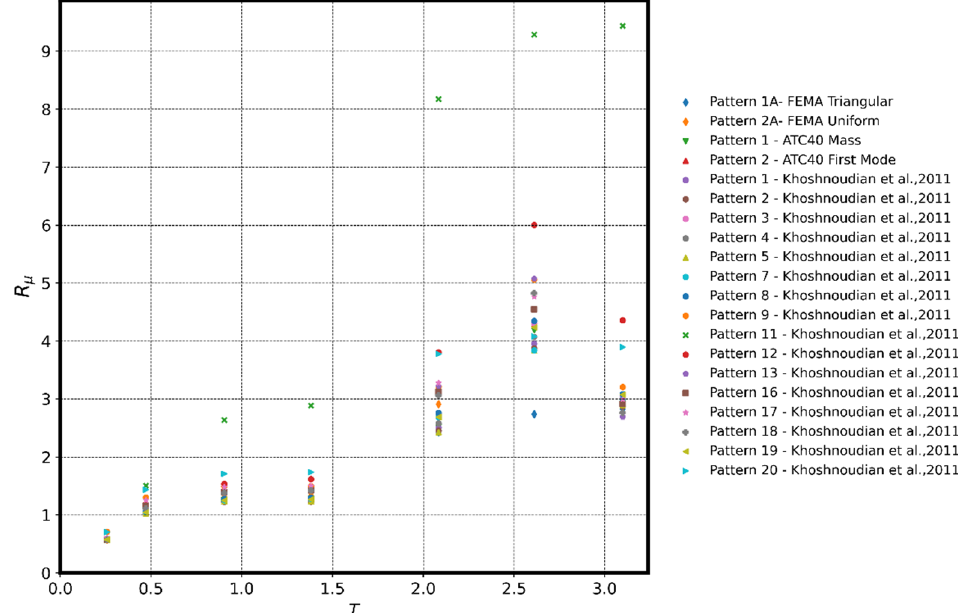
Figure 8. Overstrength factor versus period for different patterns.